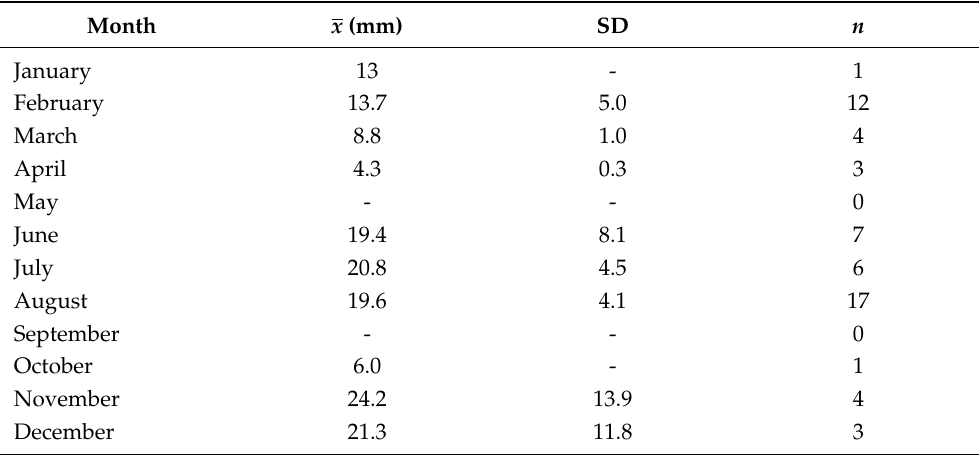
Table 3. Monthly variation in the mean oocyte diameter of U. chilensis in the Southern Gulf of California. x = Mean, SD = Standard Deviation, n = Number of Individuals. Month x (mm) SD